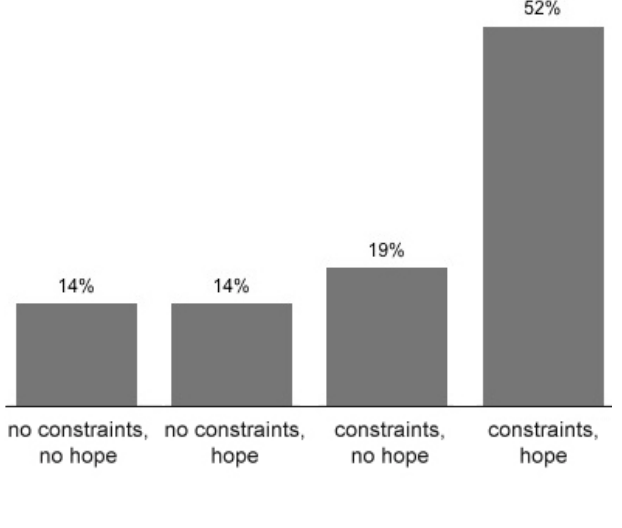
Fig. 4. Respondents’ perceptions of existing legal constraints and expectations for changes were